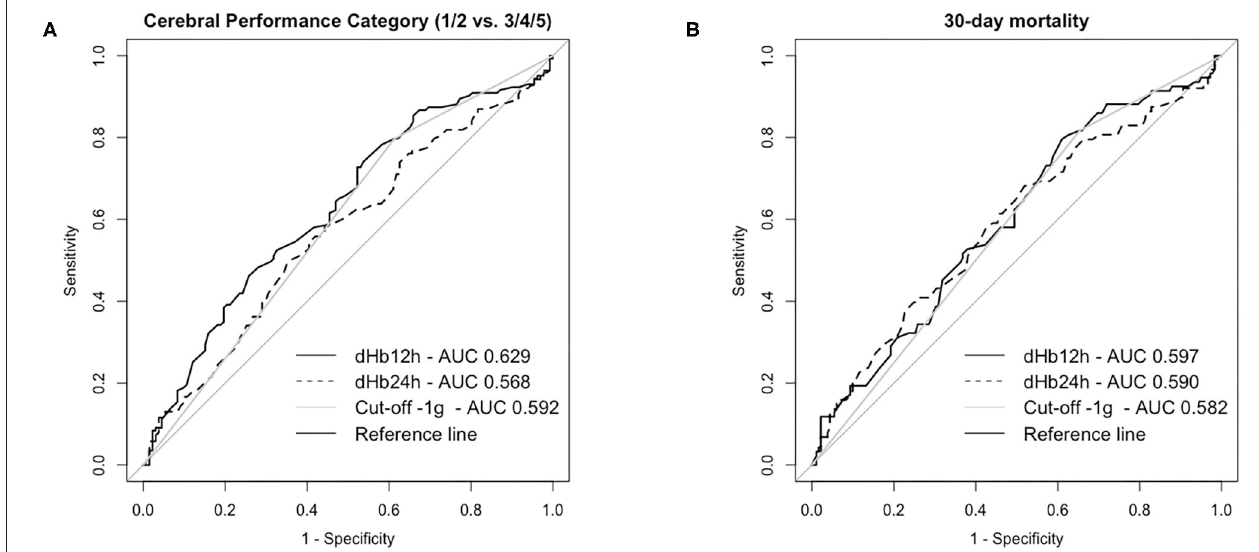
FIGURE 2 | Receiver Operating Characteristic Curves for neurologic outcome (A) and mortality (B) at day 30 in patients successfully resuscitated from cardiac arrest. dHb12h = Hemoglobin (Hb) levels 12h after return of spontaneous circulation (ROSC)—Hb levels on admission; dHb24h = Hb levels 24h after ROSC—Hb levels on admission; Cut-off − 1g: categorized data for patients with < / ≥ -1g difference for Hb levels after 12 h—Hb levels on admission.